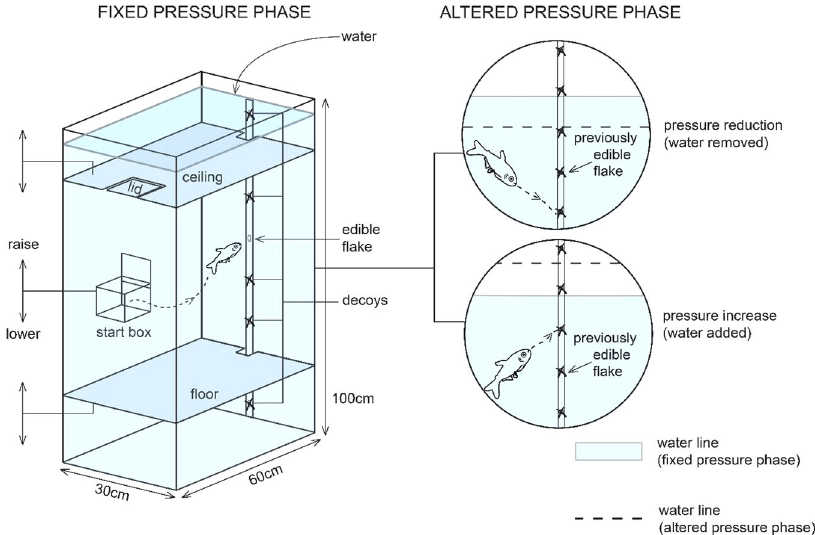
Fig. 2 Schematic diagram of experimental setup during the fi xed pressure phase and predicted search locations during the altered pressure phase. Fixed pressure phase: The lower dark-grey platform represents the mobile fl oor and the upper platform represents the mobile ceiling. The small circle at the fi sh ’ s mouth represents the edible fl ake fastened to a narrow rectangular piece of clear acrylic using petroleum jelly; the crosses on the acrylic represent the inaccessible decoy fl akes. Altered pressure phase: diagram of predicted fi sh search depths during the altered pressure phase, representing the prediction after pressure was reduced (upper circle) and after pressure was increased (lower circle).